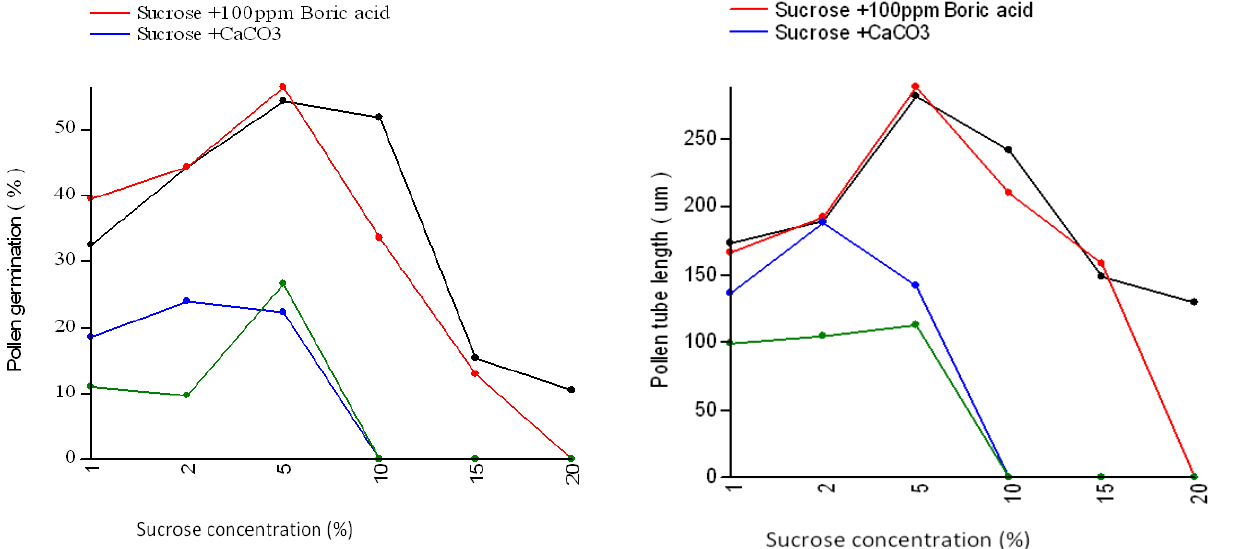
Fig. 1. Graph showing effect of different concentration of media on pollen germination Tab. 3. Effect of CaCO and sucrose solution in pollen Tab. 4. Effect of MgSO 3